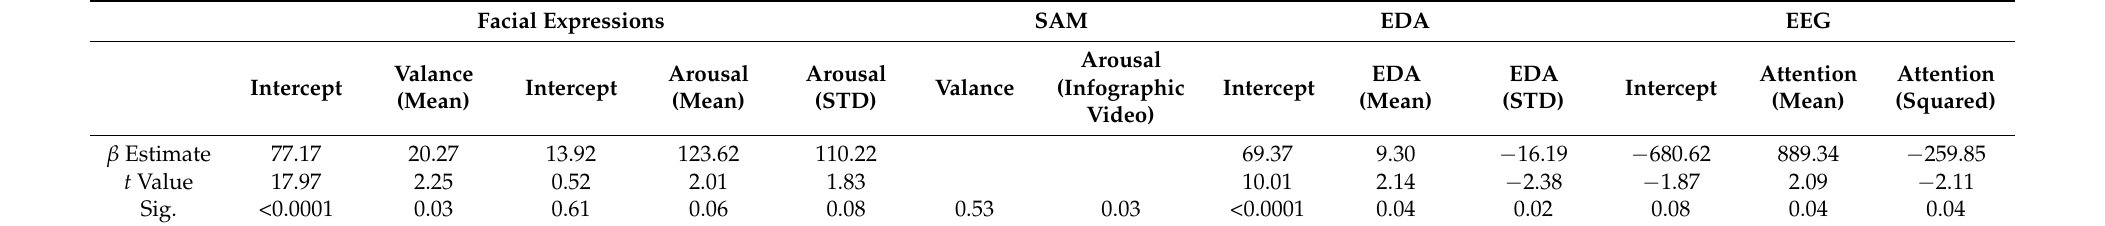
Table 4. Regression results for the relationship between engagement measures and learning